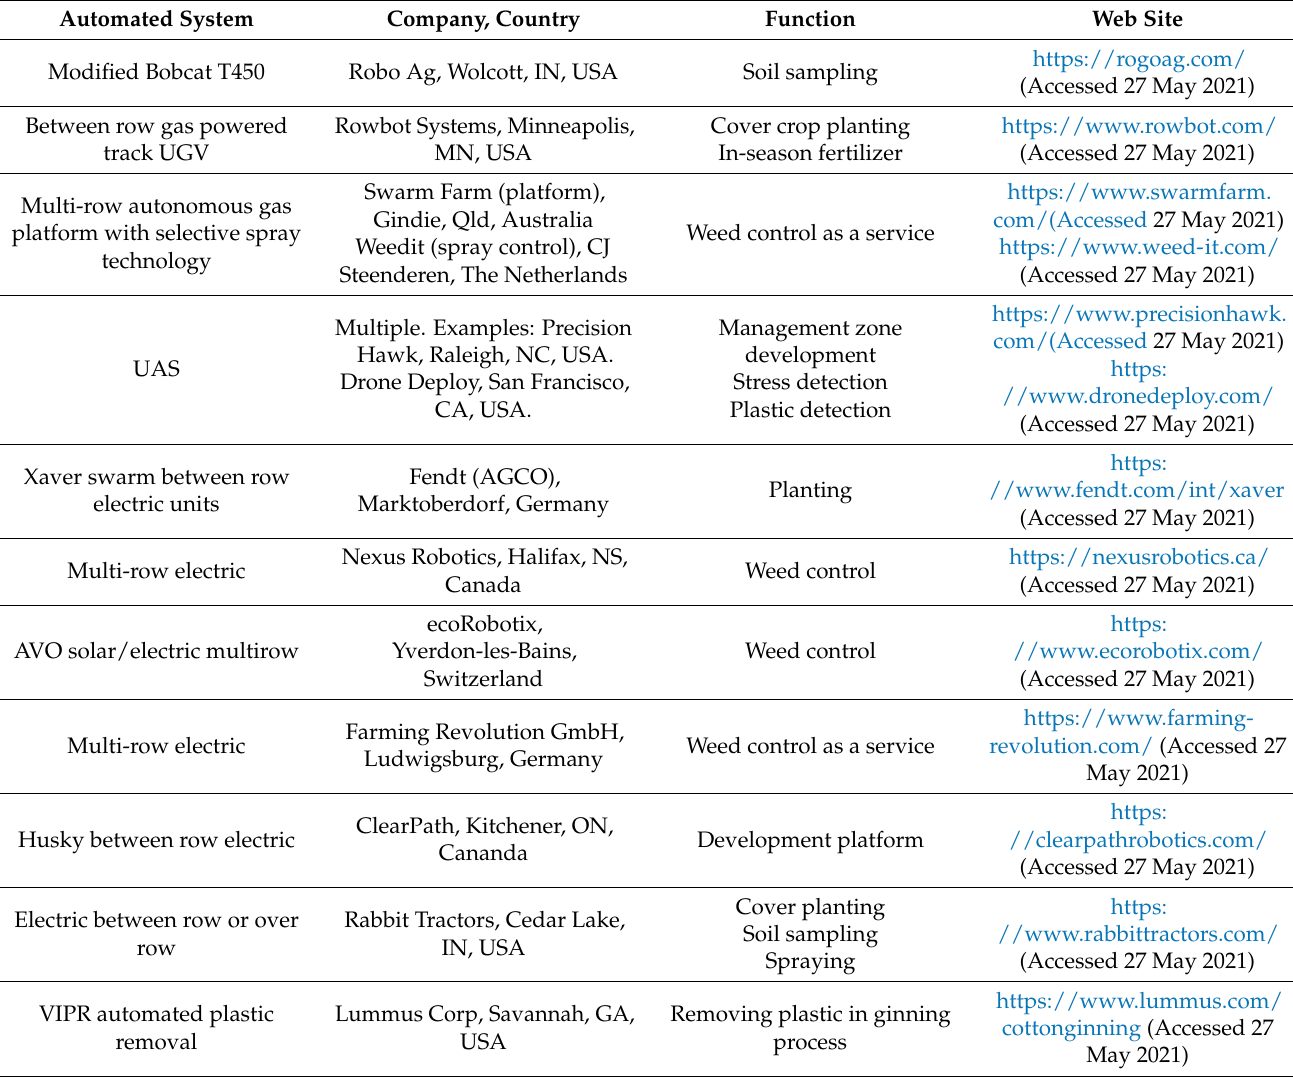
Table 2. Examples of autonomous systems currently used in agriculture or with advance prototypes with application to cotton. Automated System